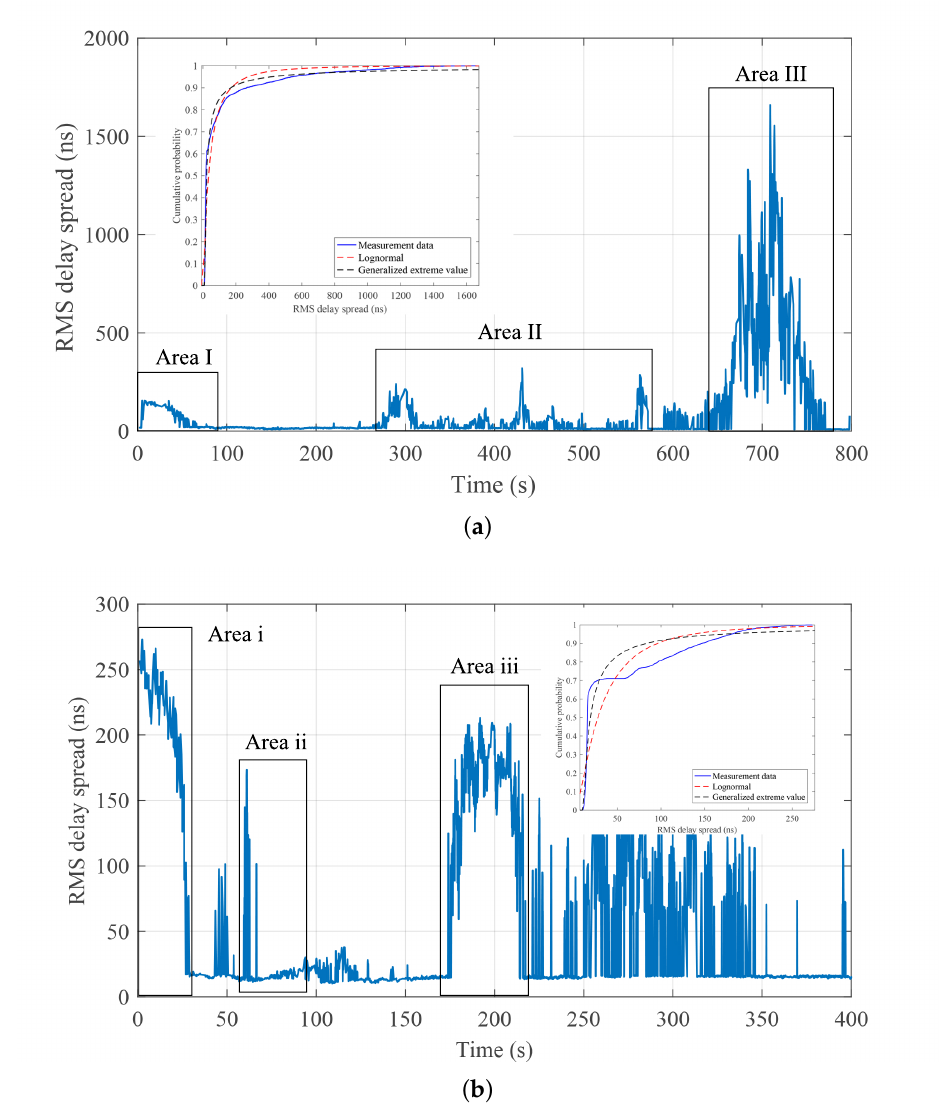
Figure 4. RMS delay spread and the statistical result of the measurements. ( a ) is for S2I and ( b ) is for